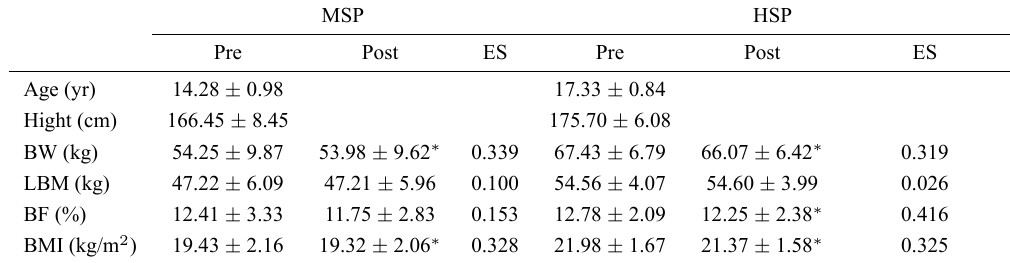
Table 2. Training effects for general characteristics of all participants.